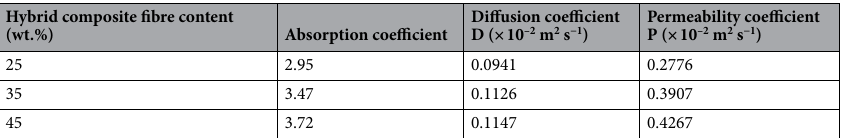
Table 4. Diffusion, sorption, and permeability coefficients for all CGF/AFF/PF hybrid composites.